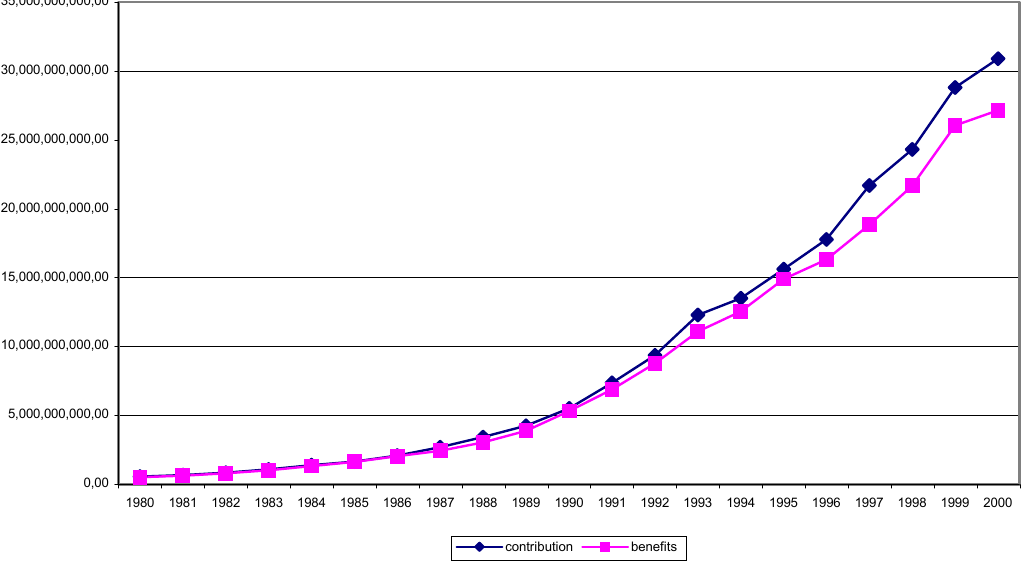
Figure 4: Contributions versus benefits Source: Council for Medical Schemes